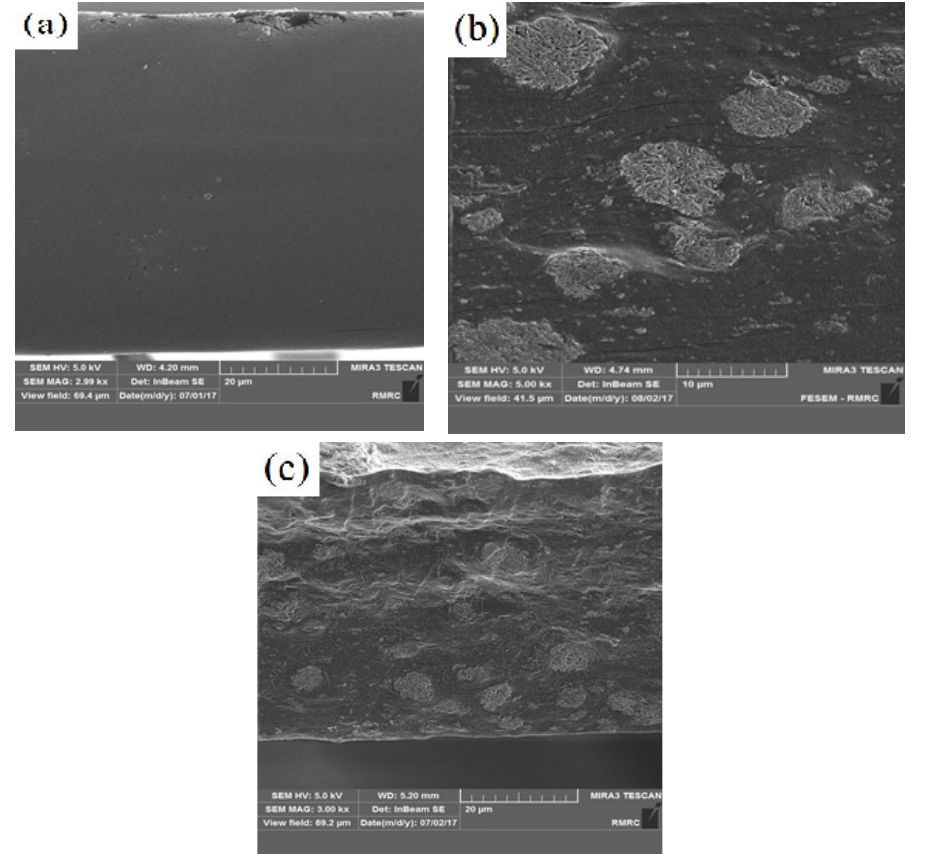
Fig. 1. SEM Images of pure chitosan (a), chitosan-ZnO (b) and chitosan-ZnO containing pomegranate peel extract 0.5%